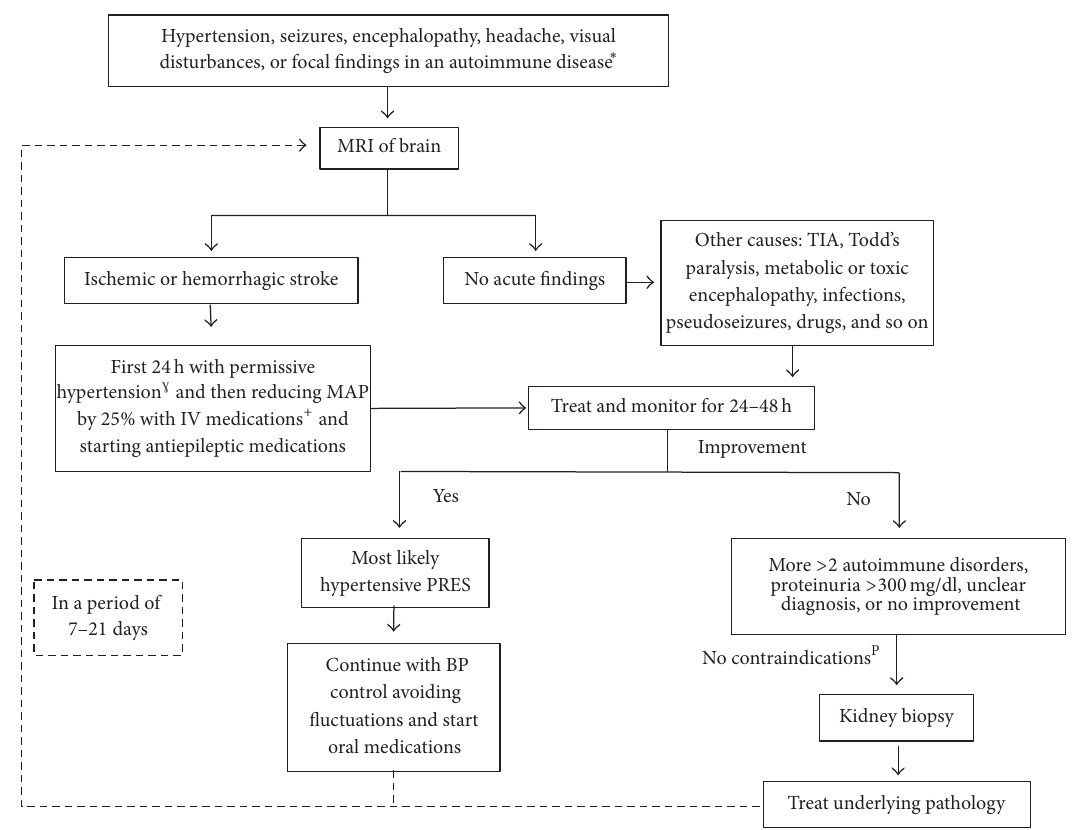
Figure 3: Diagnostic approach for the evaluation of possible PRES in patients with baseline autoimmune disease. It needs more than 2 criteria present for kidney biopsy. MRI: magnetic resonance; MAP: mean arterial blood pressure; PRES: posterior reversible encephalopathy syndrome; BP: blood pressure; TIA: transient ischemic attack. ∗ Systemic Lupus Erythematous, antiphospholipid syndrome, polyarteritis nodosa, cryoglobulinemia, thrombotic thrombocytopenic purpura, scleroderma, granulomatosis with polyangiitis, antiglomerular basement membrane antibody disease, rheumatoid arthritis, Sj¨ogren syndrome, Crohn’s disease, ulcerative colitis, autoimmune hepatitis, type 1 diabetes mellitus, Grave’s disease, Hashimoto thyroiditis, and neuromyelitis optica. + Preferably, nicardipine, labetalol, nitroprusside, enalaprilat, or hydralazine. P Kidneys < 9cm, solitary native kidney, multiple, bilateral cysts, or renal tumor; uncorrectable bleeding diathesis, severe hypertension or hemodynamic instability, hydronephrosis, active renal infection, skin infection over biopsy site, severe anatomic abnormalities, and uncooperative patient. › Permissive hypertension defined as follows: no need for BP control unless SBP > 220 mmHg, DBP > 120mmHg,andpatienthasactiveischemiccoronarydisease,heartfailure,aorticdissection,acuterenalfailure,hypertensiveencephalopathy, preeclampsia/eclampsia, or indications for thrombolytic therapy (maintaining BP < 185/110